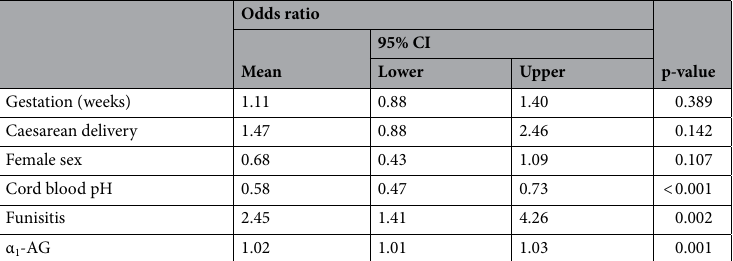
Table 3. Multivariate logistic model to explain the development of meconium aspiration syndrome. α 1 -AG was measured from umbilical cord blood or peripheral venous blood samples obtained approximately 1 h